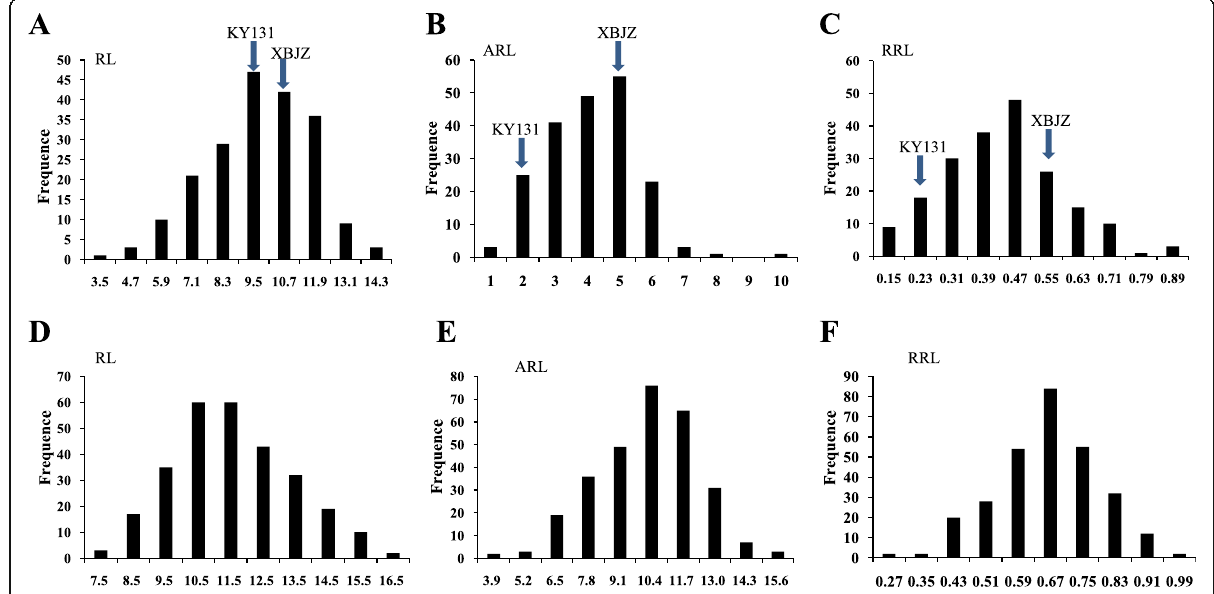
Fig. 1 Phenotypic variation in the RL, ARL, and RRL in RILs and 295 japonica rice varieties. a , b and c represent the RL, ARL, and RRL of RILs, respectively; d , e , and f represent the RL, ARL, and RRL of natural populations,